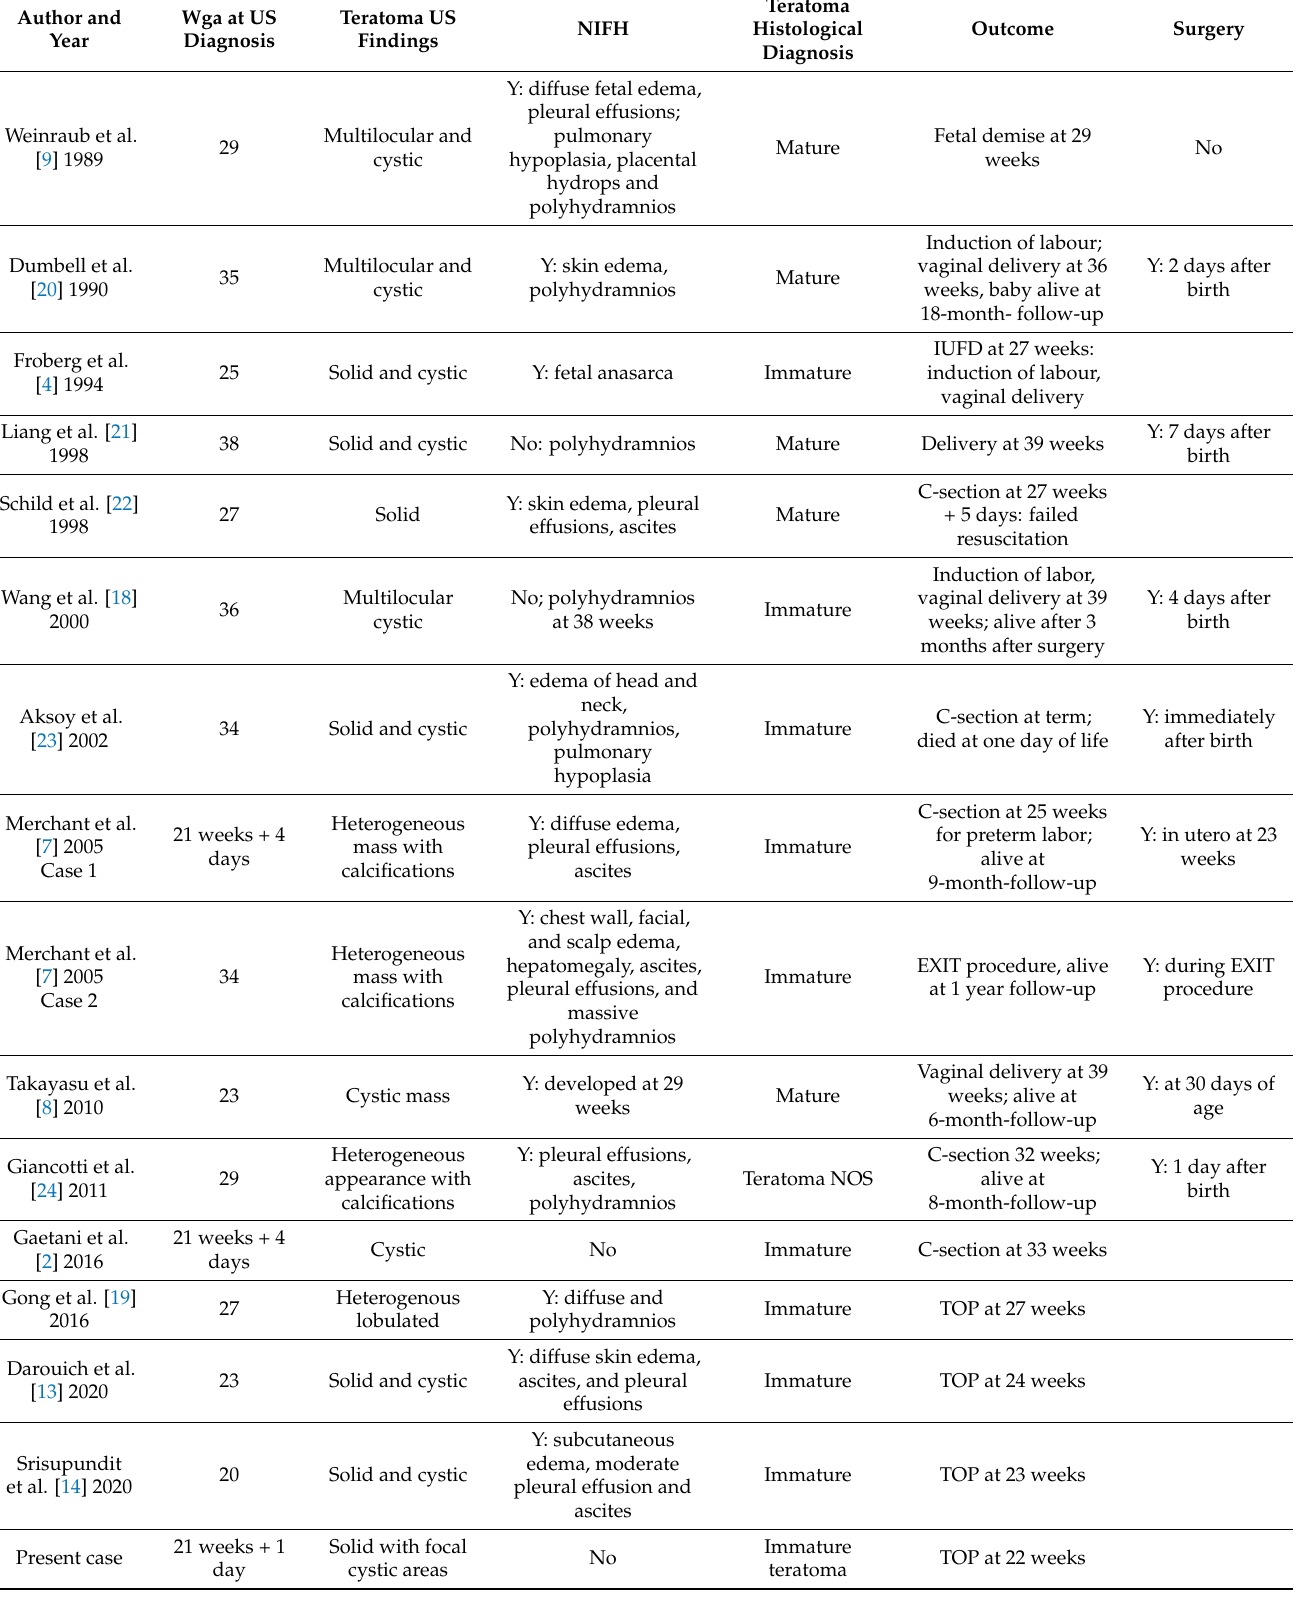
Table 1. Fetal cases currently reported with prenatal ultrasound (US) of mediastinal teratoma. Wga: weeks of gestational age; NIFH: Non Immune Fetal Hydrops; Y: yes; NOS: not otherwise specified. TOP: termination of